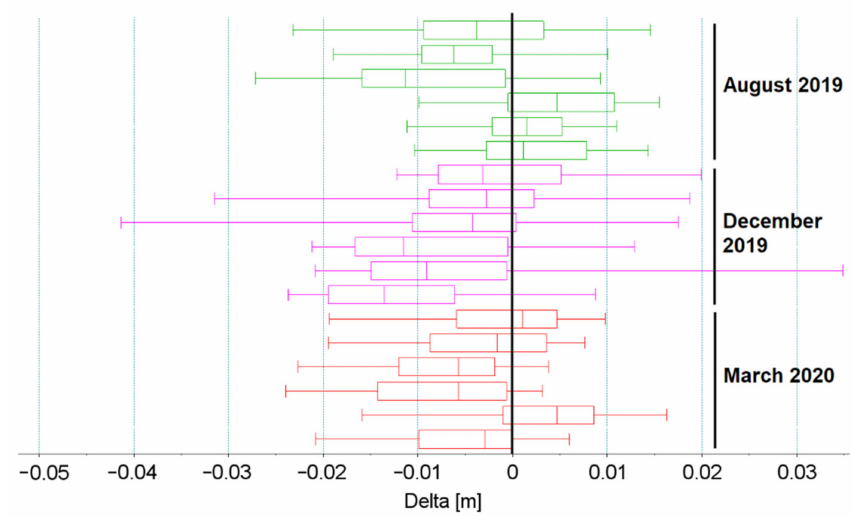
Figure 13. Box plot of deviations of the track axis reconstructed in horizontal plane using different measuring instruments with respect to the static measurement.